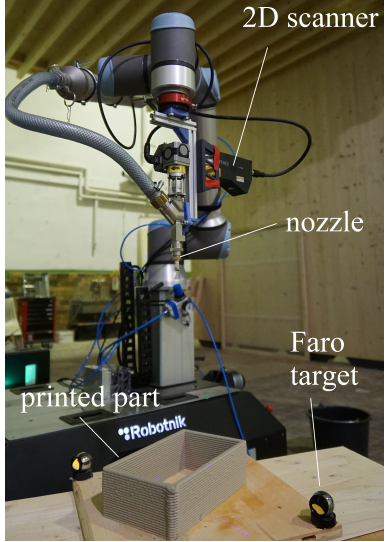
Figure 5. 3D-printing setup for the first experiment of preliminary localization validation.